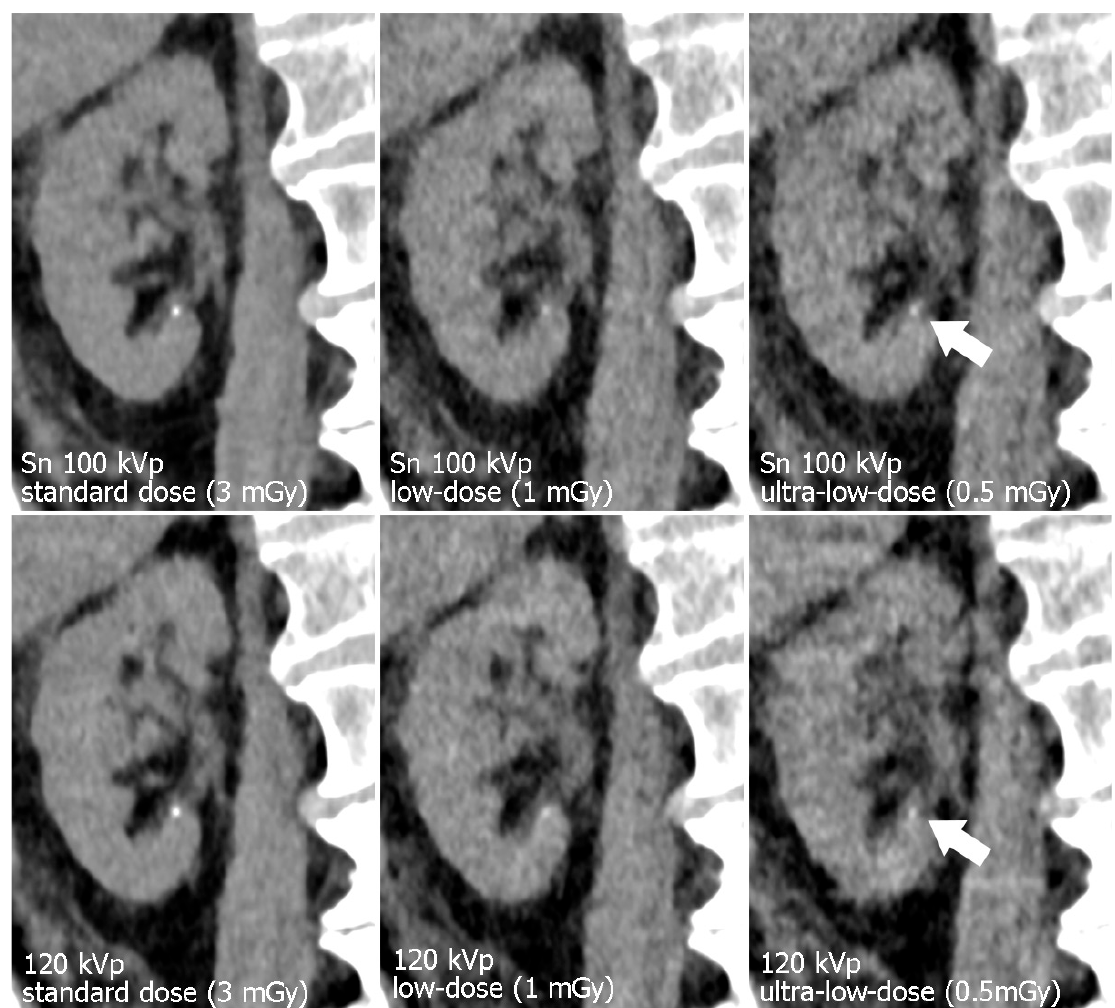
Figure 3. Para-coronal images displaying the left kidney. The renal pelvis is not dilated but pelvic structures remain assessable even in ultra-low-dose images. Note the increased noise in the 120 kVp ultra-low-dose study compared to the dose-matched protocol with tin filtration.